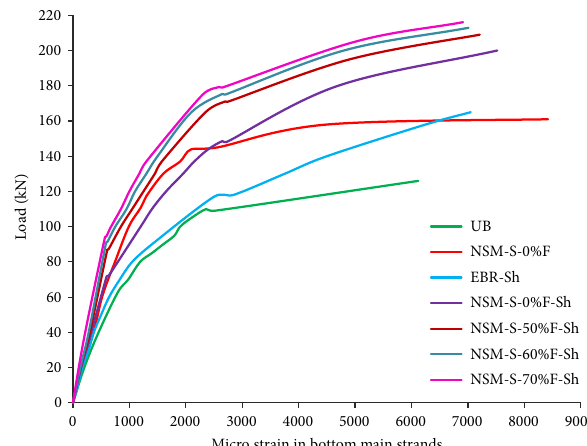
Figure 8. Load versus tensile strain in bottom main strands